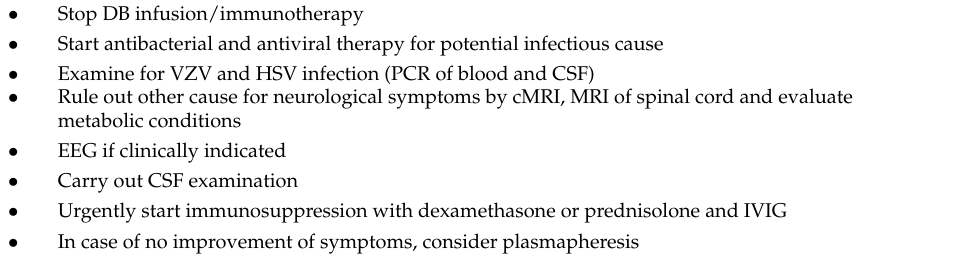
Table 4. Management recommendations for suspected neurotoxicity during immunotherapy with